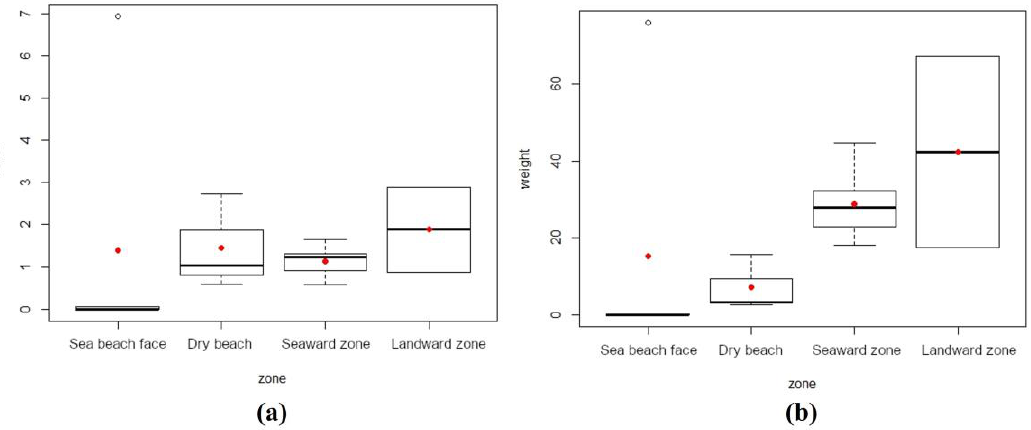
Figure 4. Box plots concerning Caribbean Sea beach/mangrove zones. ( a ) Litter abundance (items/m 2 ). ( b ) Weight of litter items (g/m 2 ). Red dots represent mean values and black lines median values.